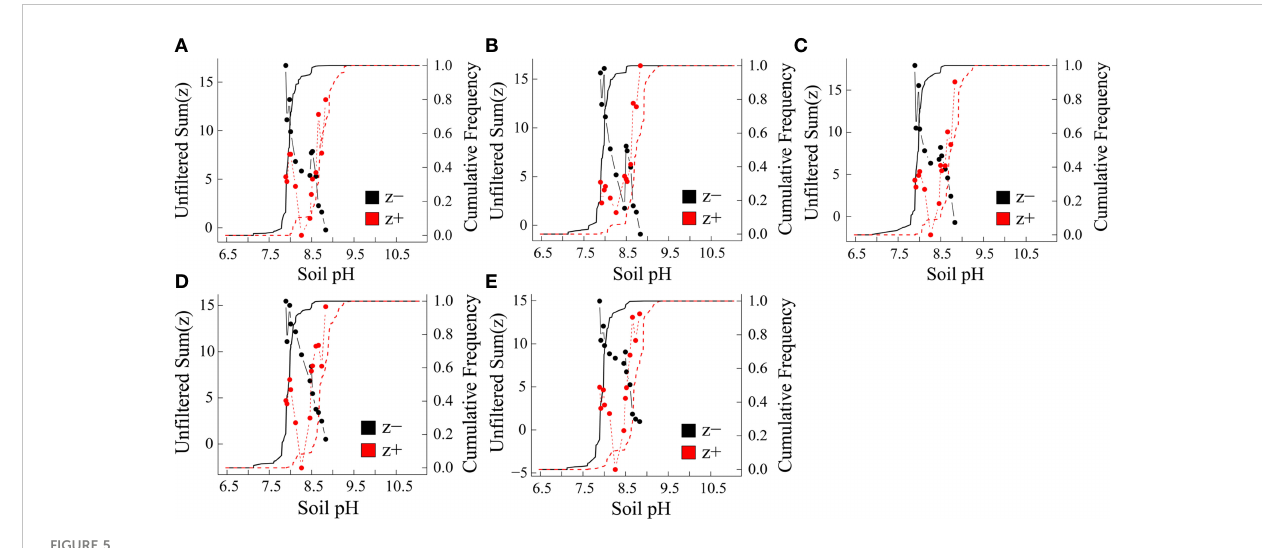
FIGURE 5 Leaf microelement concentrations and bioconcentration factors (BCFs) in response to soil pH. (A) Mn (B) Fe (C) Ni (D) Cu and (E) Zn. Black and red symbols present accumulative negative (sum z-) and positive (sum z+) responses, respectively. Vertical dashed lines indicate pH gradient thresholds corresponding to maximal sum